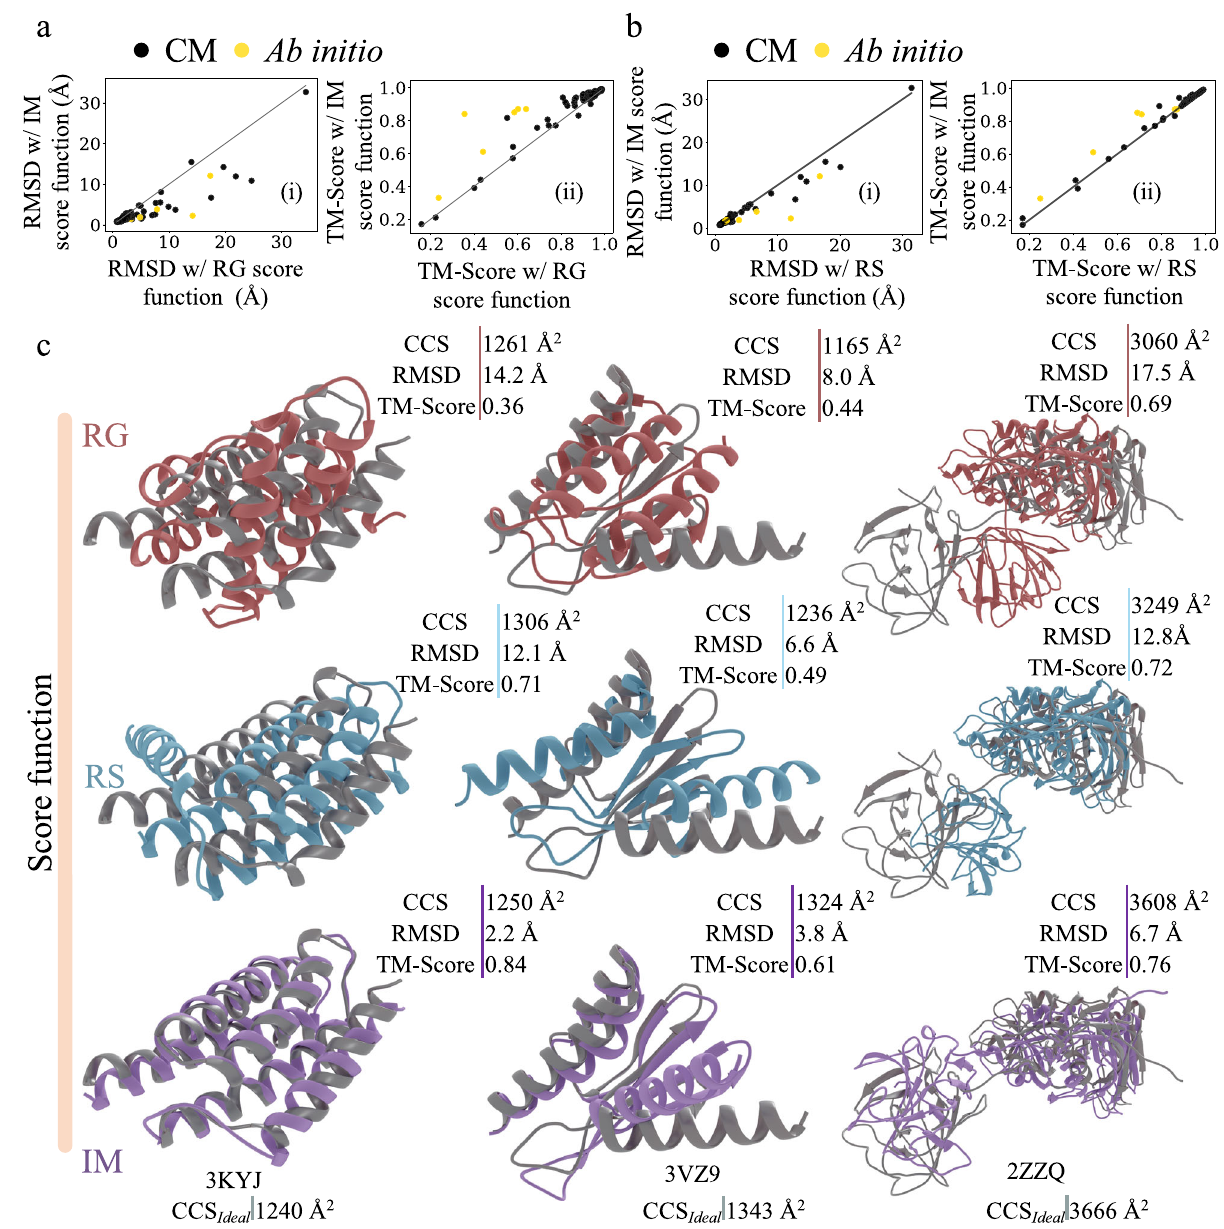
Fig. 2 | Protein structure prediction with and without ideal ion mobility (IM) data. Consistent improvement in model selection was observed when using the IM score function for the 60 proteins in the ideal dataset. The predicted models from the IM score function were compared to that of the a radius of gyration (RG) and b Rosetta (RS) score functions in terms of their respective (i) root mean square